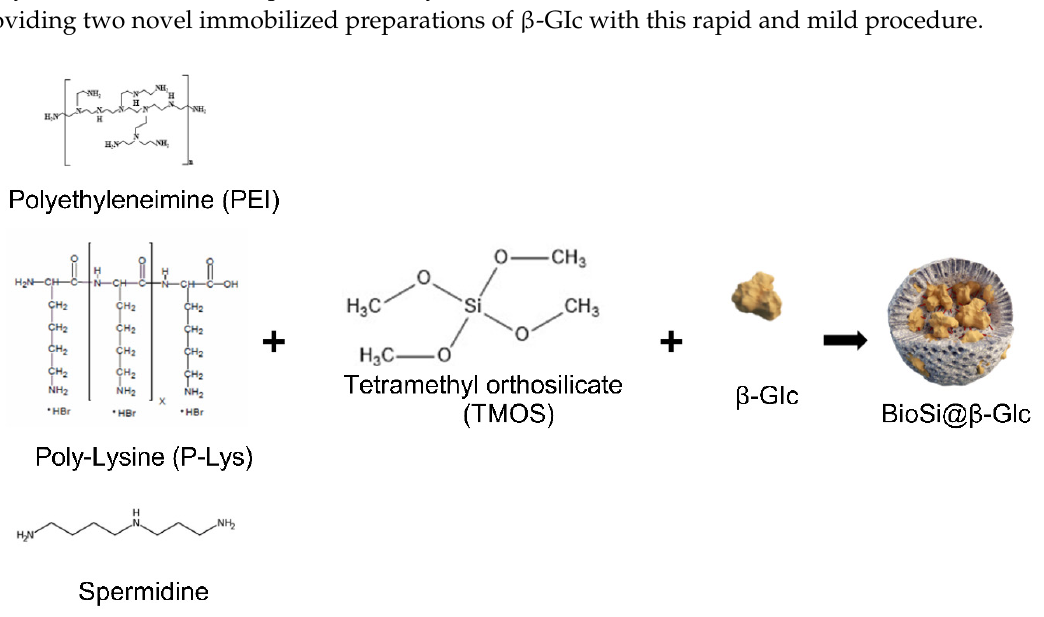
Scheme 1. Schematic representation of the immobilization strategies using different amine catalysts.